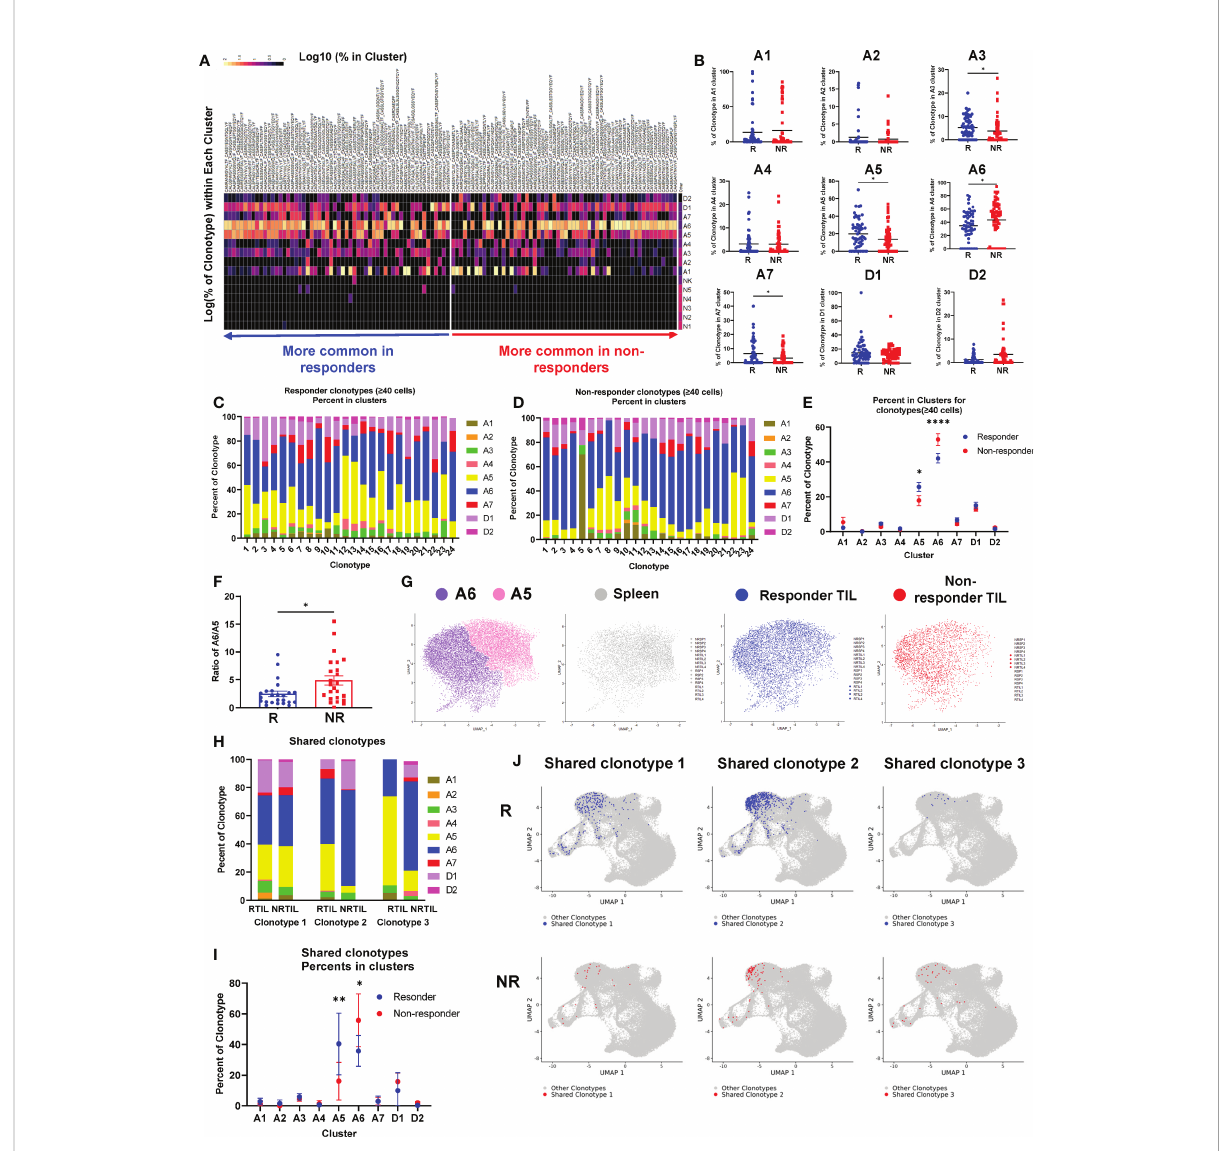
FIGURE 5 Top TCR clonotypes of CD8 TILs differentially occupy activation clusters in responders (R) vs . non-responders (NR). (A) Heatmap of the log10 percent of top TCR clonotypes (n=58 per group, >0.65% in R TIL or >1% in NR TIL samples) residing in each cluster of the UMAP. (B) Quanti fi cation of percent of R (blue) or NR (red) top TCR clonotypes residing in activated clusters (A1-A7) and dividing clusters (D1-D2) of the UMAP. Each dot represents a clonotype and the black line indicates the mean. Groups were compared using unpaired t-test with Mann-Whitney U test correction for non-parametric data (*, P <0.05). (C, D) All top TCR clonotypes from R (C) or NR (D) containing at least 40 cells are shown as bar graphs with the percent of clonotype in each cluster (A1-A7, D1-D2) broken down. (E) Quanti fi cation of percent of R clonotypes (blue) in (C) and NR clonotypes (red) in (D) in each cluster of the UMAP. Data were presented as mean ± SEM. Statistical signi fi cance was calculated with two-way ANOVA followed by Sidak ’ s multiple comparisons test (*, P <0.05; ****, P <0.0001). (F) Ratio of the percent in A6 vs . the percent in A5 (% in A6/% in A5) for a given TCR clonotype in R (blue) or NR (red). Each dot represents a clonotype. Data were presented as mean ± SEM. Statistical signi fi cance was calculated with unpaired t test (*, P <0.05). (G) Cells in A5 and A6 clusters were extracted and plotted into one UMAP showing A5 (pink) and A6 (purple) clusters from all 16 samples, or from R TILs (blue), NR TILs (red) or splenic CD8 T cells (gray), respectively. (H – J) Three TCR clonotypes shared between R and NR CD8 TILs were identi fi ed that contained at least 20 cells in a given group (Supplemental Table 3). (H) The percent of each of the 3 shared clonotypes in each cluster (A1-A7, D1-D2) in R vs . NR TIL samples. (I) Quanti fi cation of the percent of 3 shared clonotypes in each cluster (A1-A7, D1-D2) in R vs . NR CD8 TIL samples. Data were presented as mean ± SEM. Statistical signi fi cance was calculated with two-way ANOVA followed by Sidak ’ s multiple comparisons test (* P <0.05; ** P <0.01). (J) UMAP of the CD8 T cells harboring the shared TCR clonotypes. Cells with a given TCR clonotype are shown for R TILs (blue) or NR TILs (red), over cells with all other TCR clonotypes from all samples